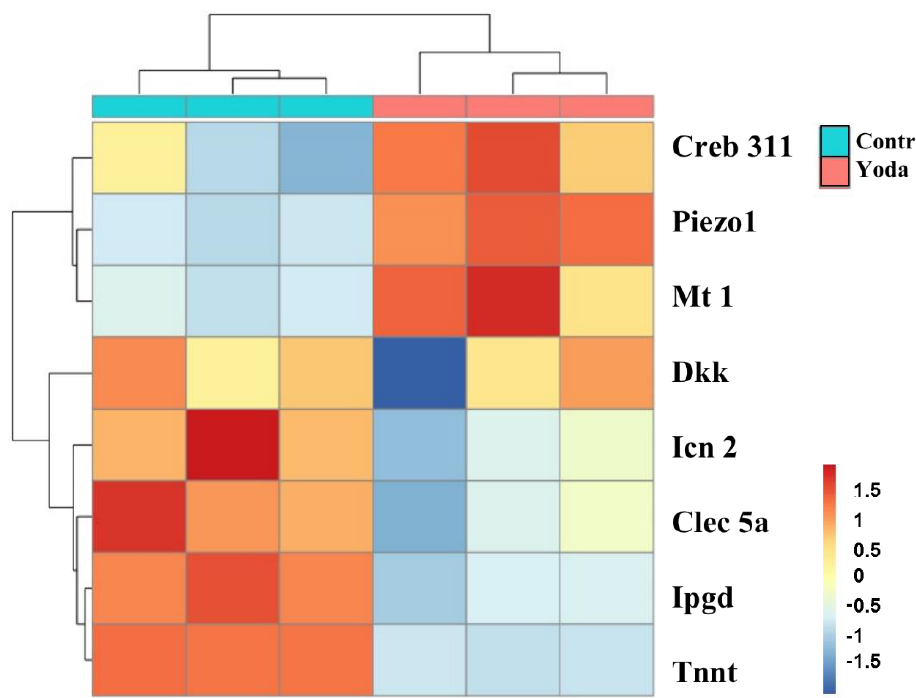
Figure 7. In vitro chondrocytes verification. Heat maps of the relative expression of most overlapping DEGs in mice primary chondrocytes.